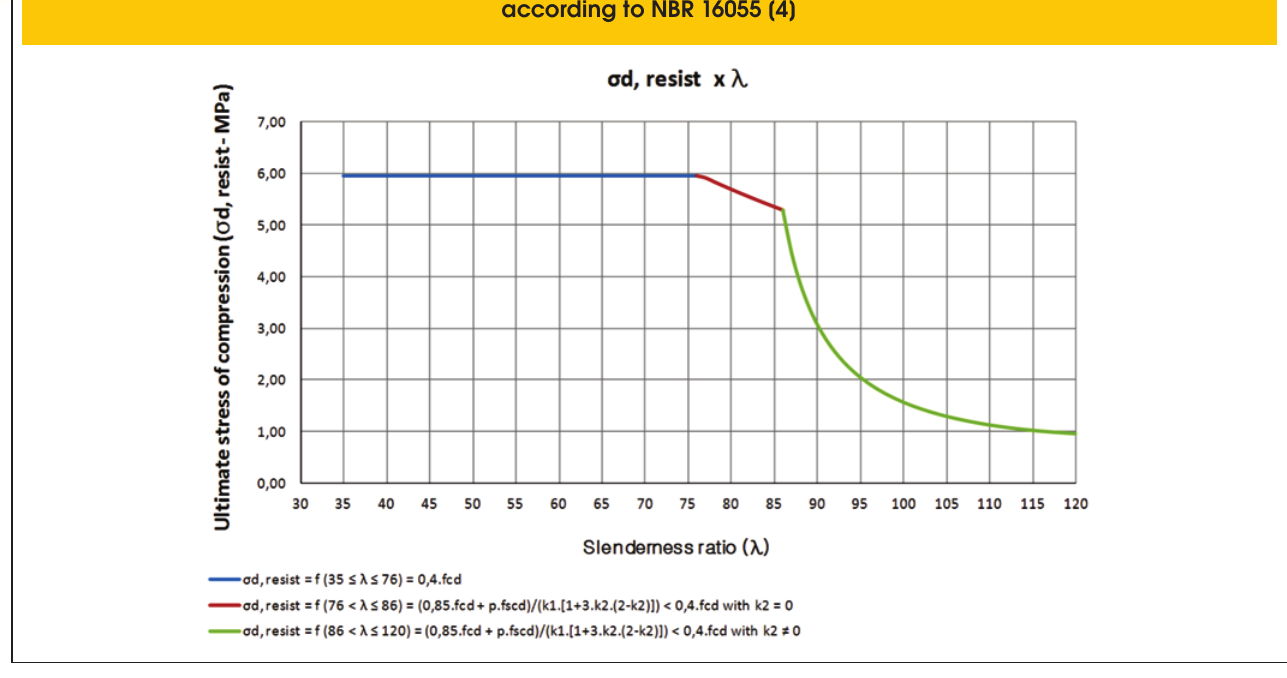
Figure 19 – Decrease of the ultimate stress of compression with increasing slenderness ratio,